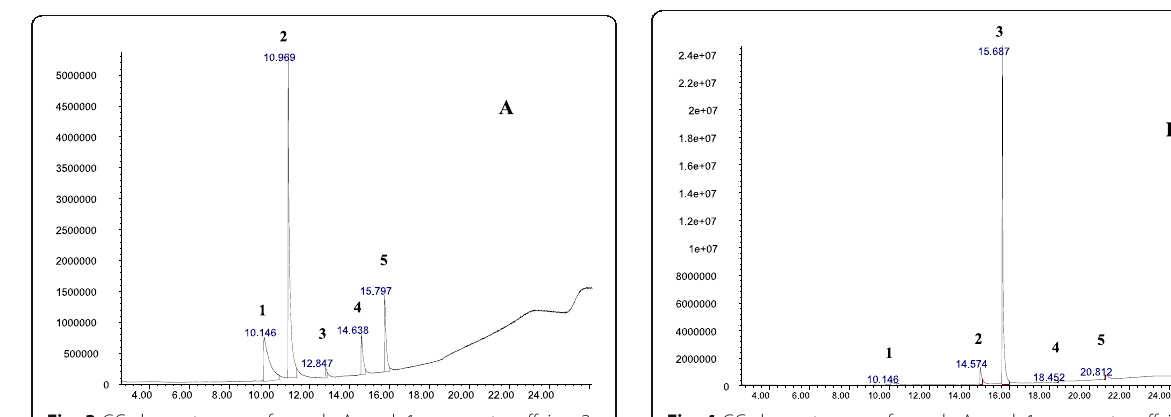
Fig. 4 GC chromatogram of sample A, peak 1 represents caffeine, 2 dextromethorphan, 3 heroin, 4 papaverine, and 5